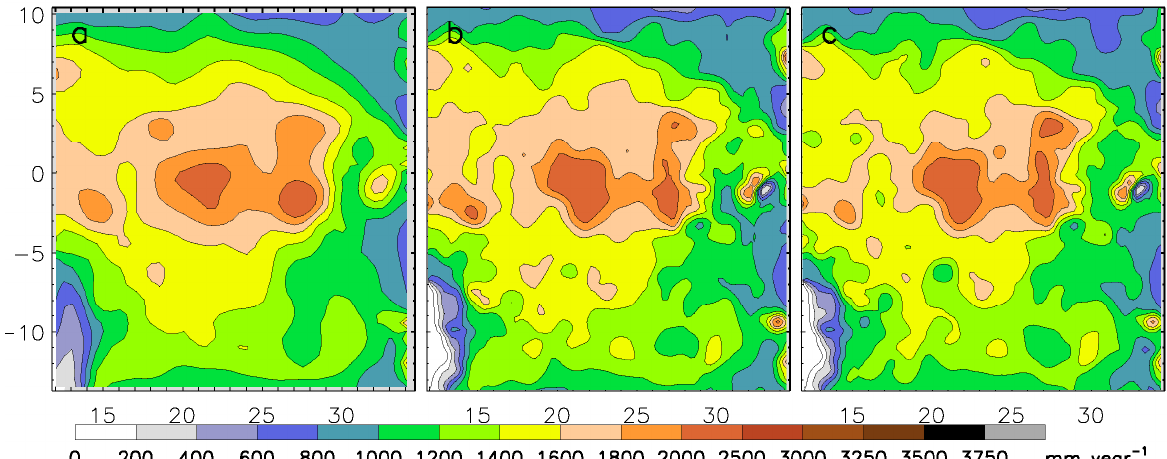
Figure 4. Mean annual rainfall based on NIC131 for the years 1945–94 ( a ), on GPCC for the years 1945–94 ( b ) and GPCC for the years 2001–20219 ( c ).